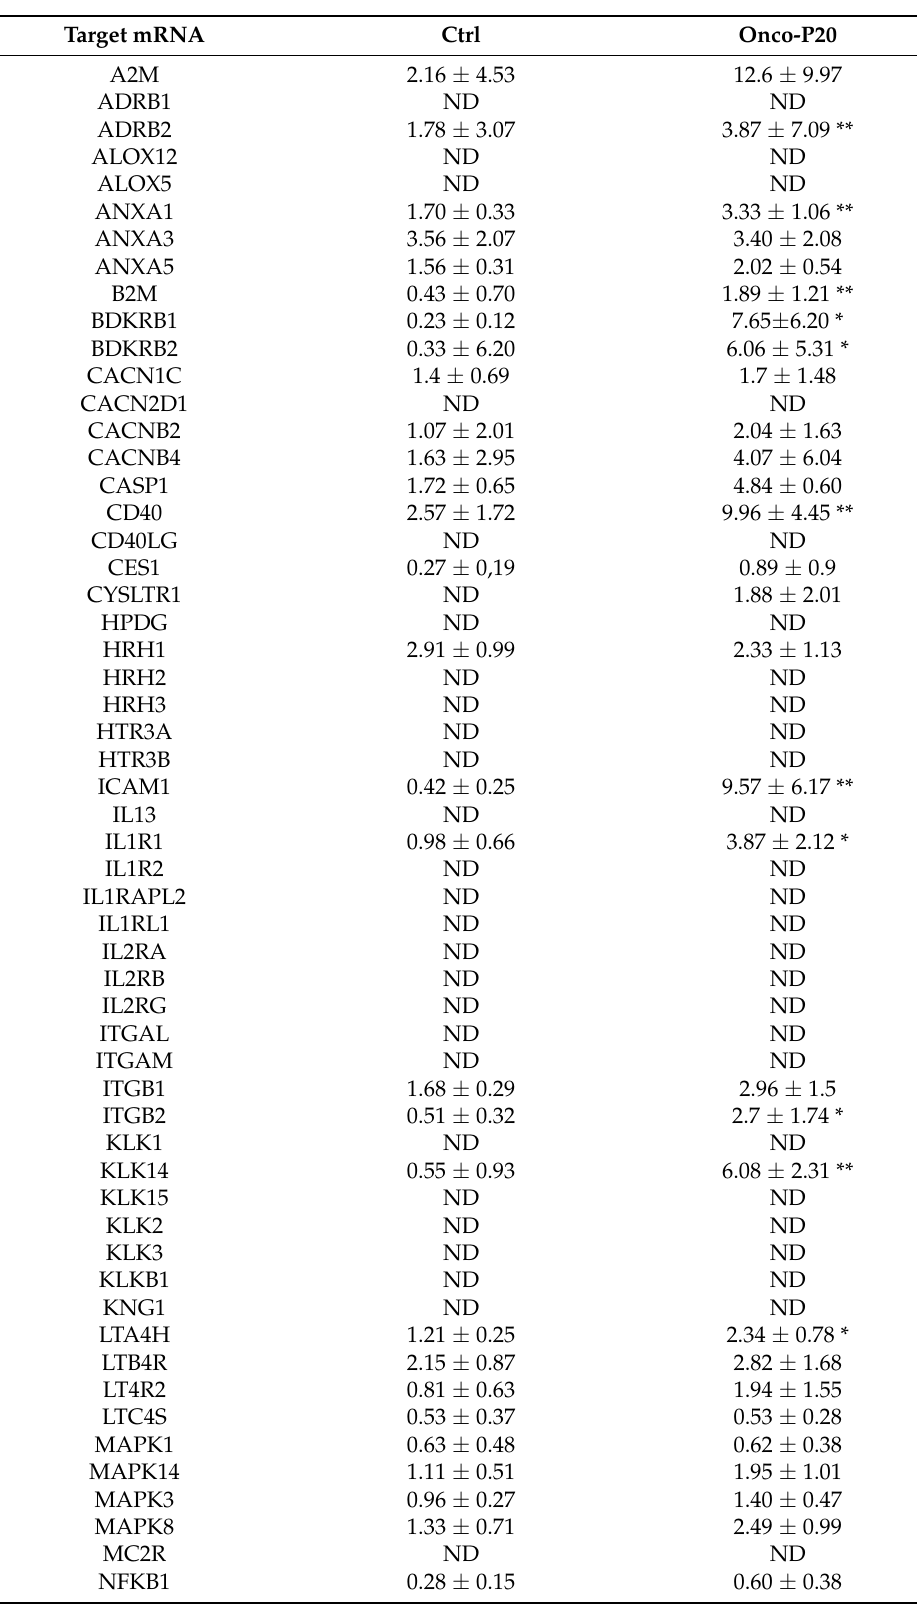
Table 2. Results of human inflammation genes array after 2 weeks of fibroblast treatment with Onco-P20 (or not control cells). Results are the mean ± SD of seven different experiments performed with fibroblasts isolated from independent donors. * p < 0.05 and ** p < 0.001. Not